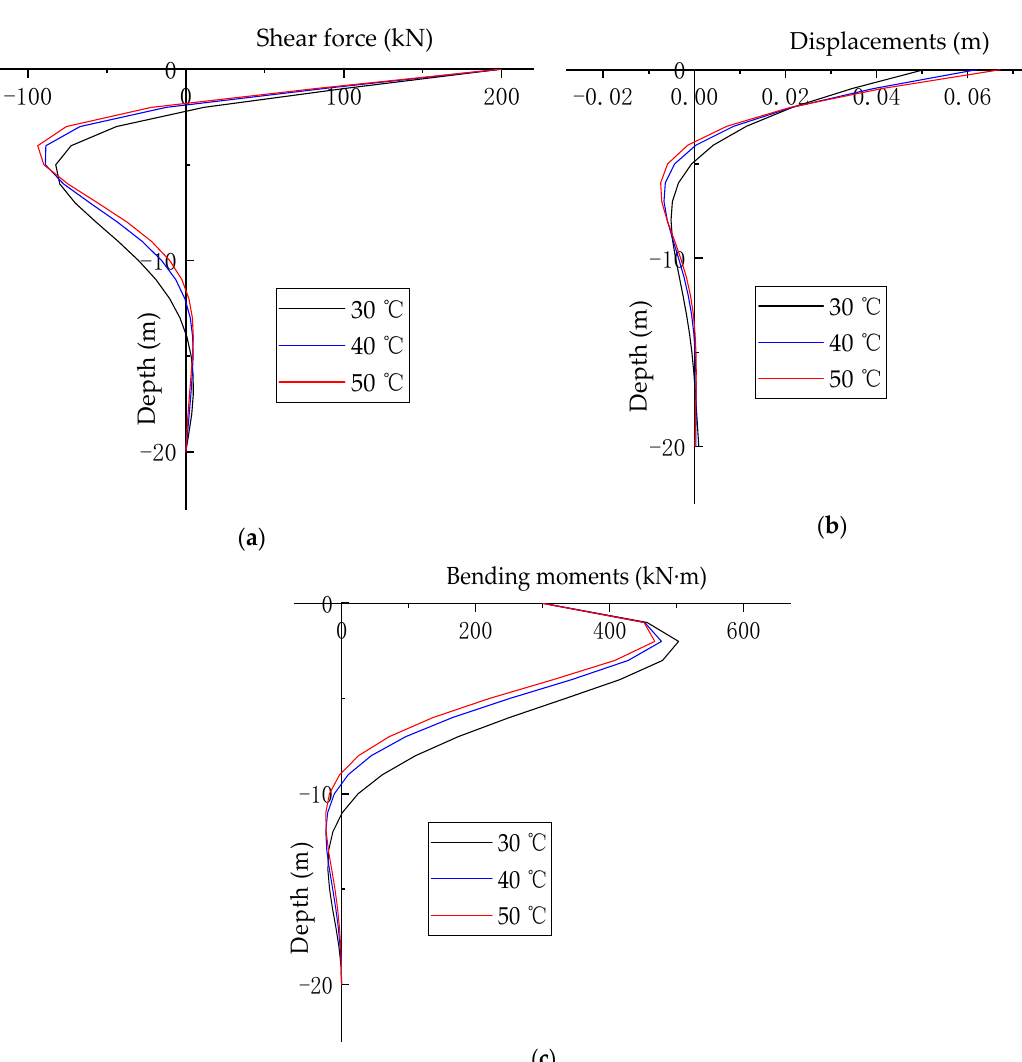
Figure 9. Internal force distribution diagrams of piles: ( a ) shear force; ( b ) displacement; ( c ) bending moment.